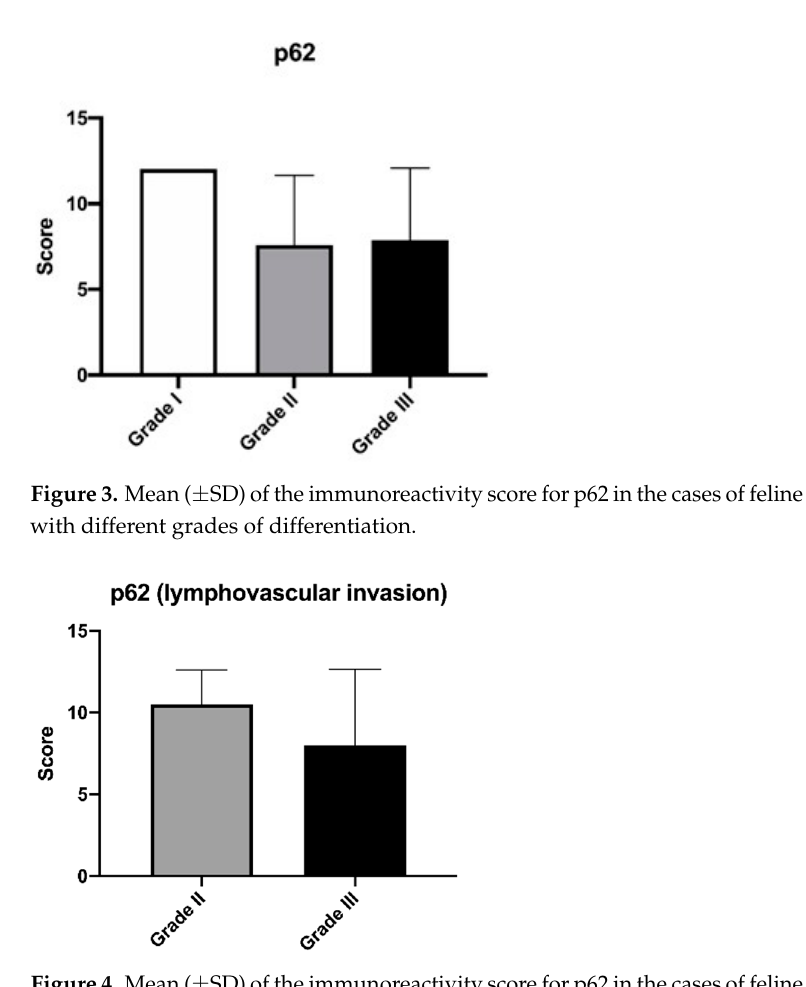
5 of 10 Figure 1. p62 immunostaining in the non-neoplastic feline mammary gland and mammary carcinoma (immunoperoxidase stain; hematoxylin counterstain). ( A ) Normal cat mammary gland negative for p62; ( B ) normal cat mammary gland slightly positive for p62; ( C ) low-grade (GI) feline mammary carcinoma with intense cytoplasmic immunolabeling; ( D ) low-grade GI feline mammary carcinoma with finely granular intense cytoplasmic immunolabeling; ( E ) intermediate-grade (GII) feline mammary carcinoma with intense cytoplasmic immunolabeling; ( F ) high-grade (GIII) feline mammary carcinoma with coarsely granular intense cytoplasmic immunolabeling; ( G ) high-grade (GIII) feline mammary carcinoma with intense granular cytoplasmic immunolabeling; ( H ) high- grade (GIII) feline mammary carcinoma with lymphovascular invasion and intense cytoplasmic immunolabeling. Figure 2. Mean (±SD) of the immunoreactivity score for p62 in the 38 cases of feline mammary carcinoma and 12 non-neoplastic tissue (*** p < 0.001). Table 1. Immunoreactivity score for p62 in the 38 cases of feline mammary carcinoma. p62 Positivity Score Low (1–2)